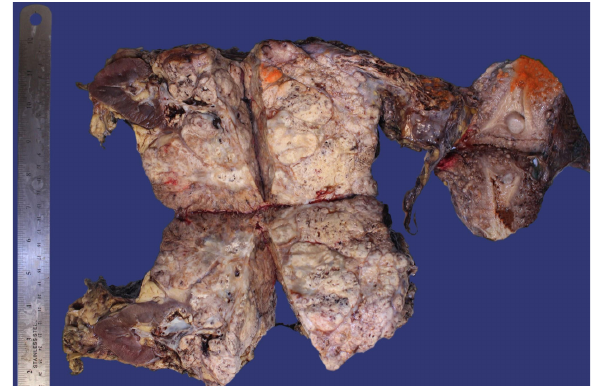
Figure 3: Gross examination of the surgical specimen revealed a large necrotic left renal mass extending via the gonadal vein to the uterus and bilateral ovaries. Figure 4: Microscopic evaluation of the tumor revealed nests